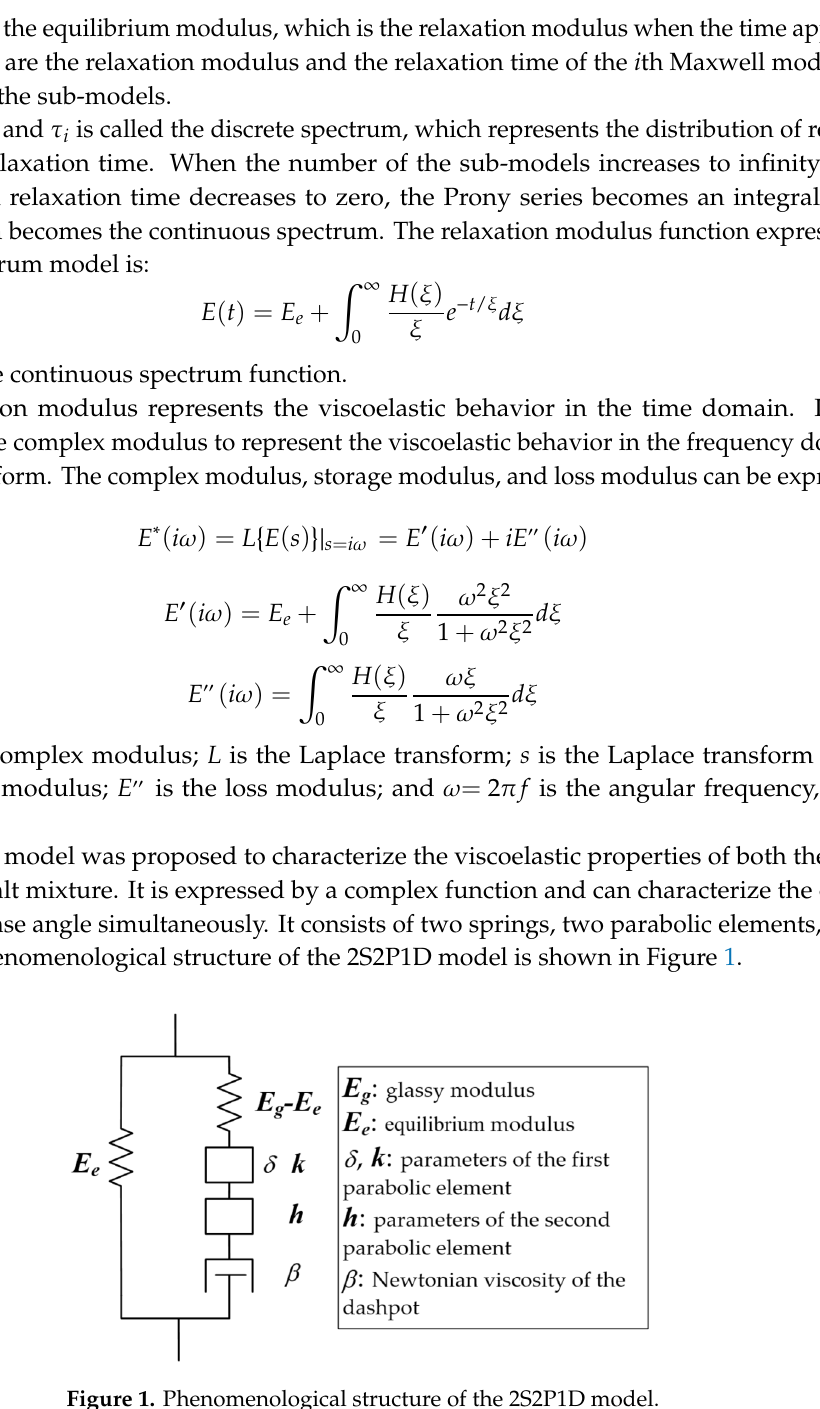
Figure 1. Phenomenological structure of the 2S2P1D model.